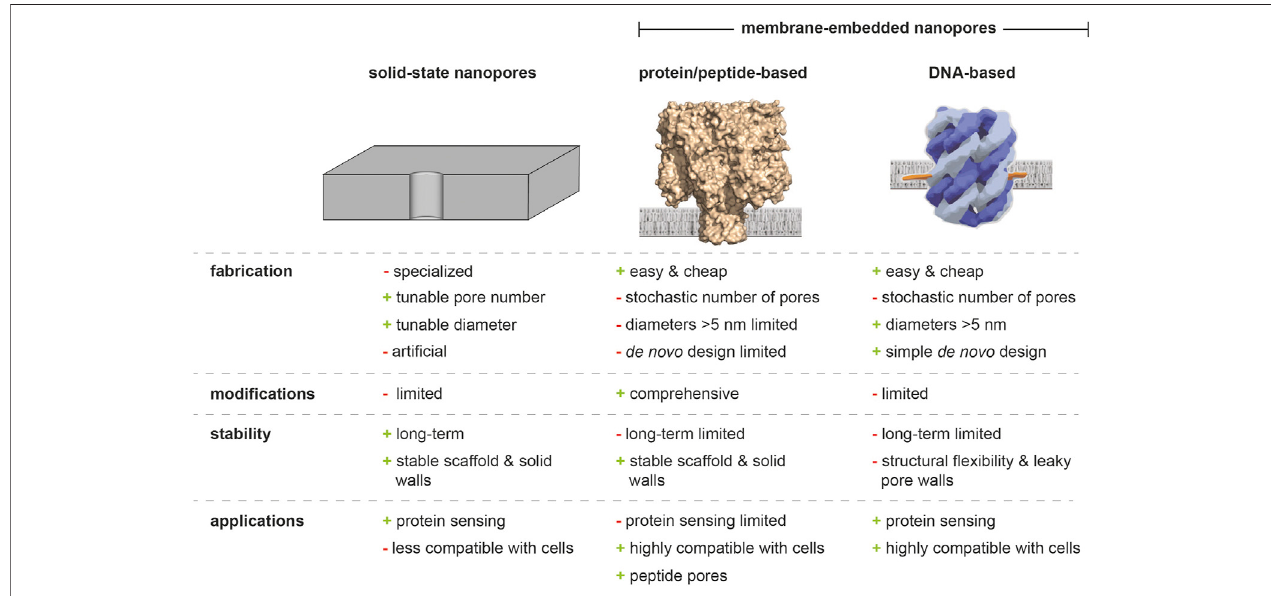
FIGURE 2 | Solid-state, protein/peptide-based, and DNA nanopores. Advantages and weaknesses of solid-state nanopores, biological nanochannels, and DNA origami-based analogues are highlighted.